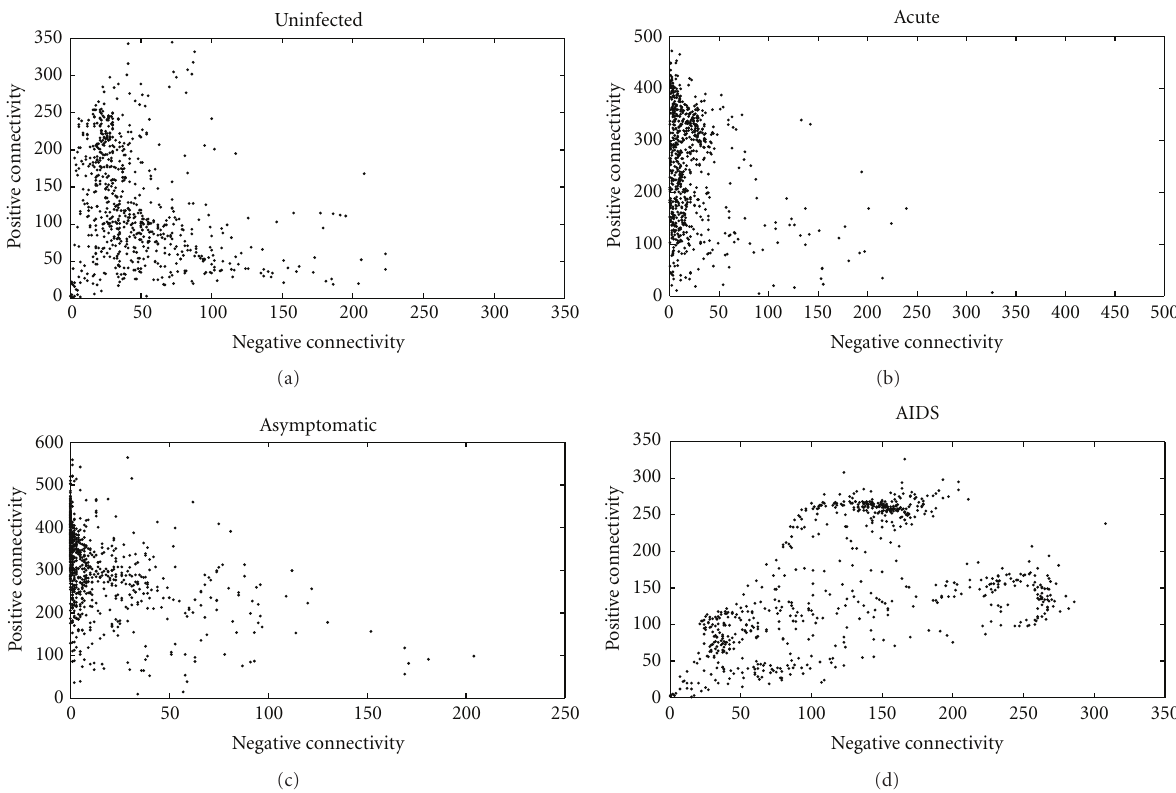
Figure 1: The dual positive-negative connectivity of genes in GCNS of the uninfected subjects (a), and infected patients at the acute (b), the asymptomatic (c), and the AIDS (d) stages. Each dot represents a gene in the GCN.